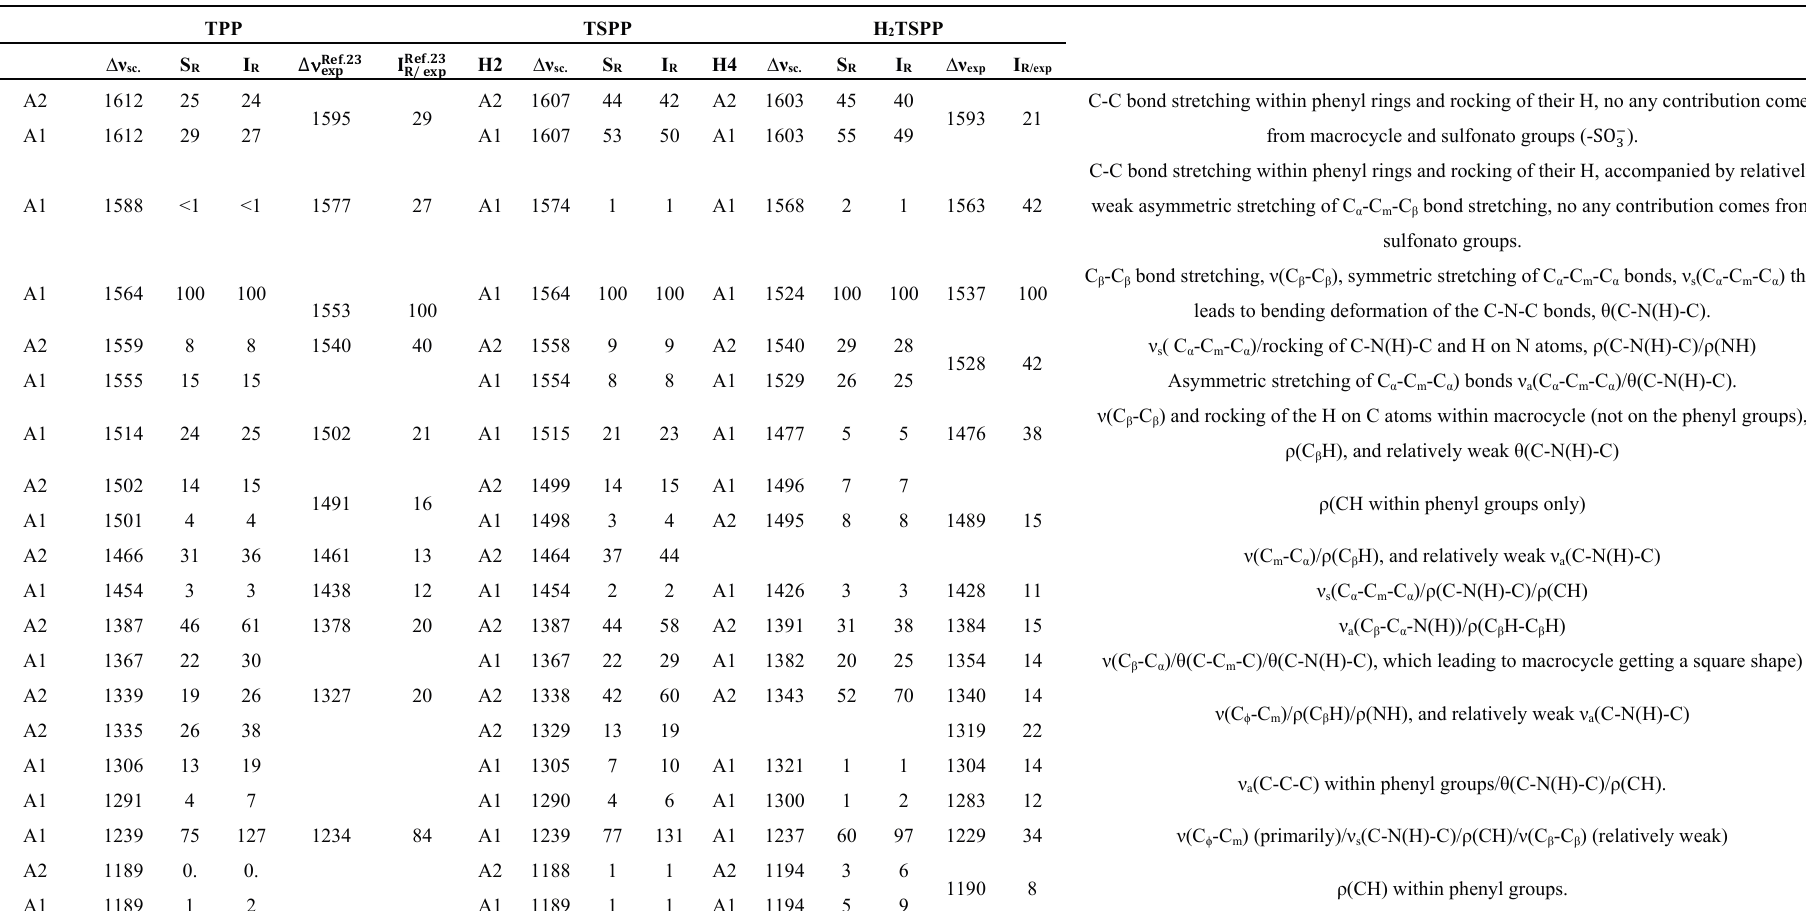
Table 2. Observed and calculated Raman active modes of frequencies (in cm − 1 ) of the H 2 TSPP (C 2v ) with the TPP (C 2v point group) and TSPP (C 2v ) for comparison. The calculations were carried out in water used as solvent at B3LYP/6-311G(d,p) level of the DFT. Where ∆ν sc stands for the scaled vibrational frequencies ( ∆ν sc. = 0.96 ∆ν calc +40) and S R and I R indicate the calculated Raman scattering activity and intesity, respectively; ∆ ν exp and I R/exp stand for the observed Raman frequency and Intensity, respectively. The experimental values of Raman spectrum of the TPP are taken from our previous work